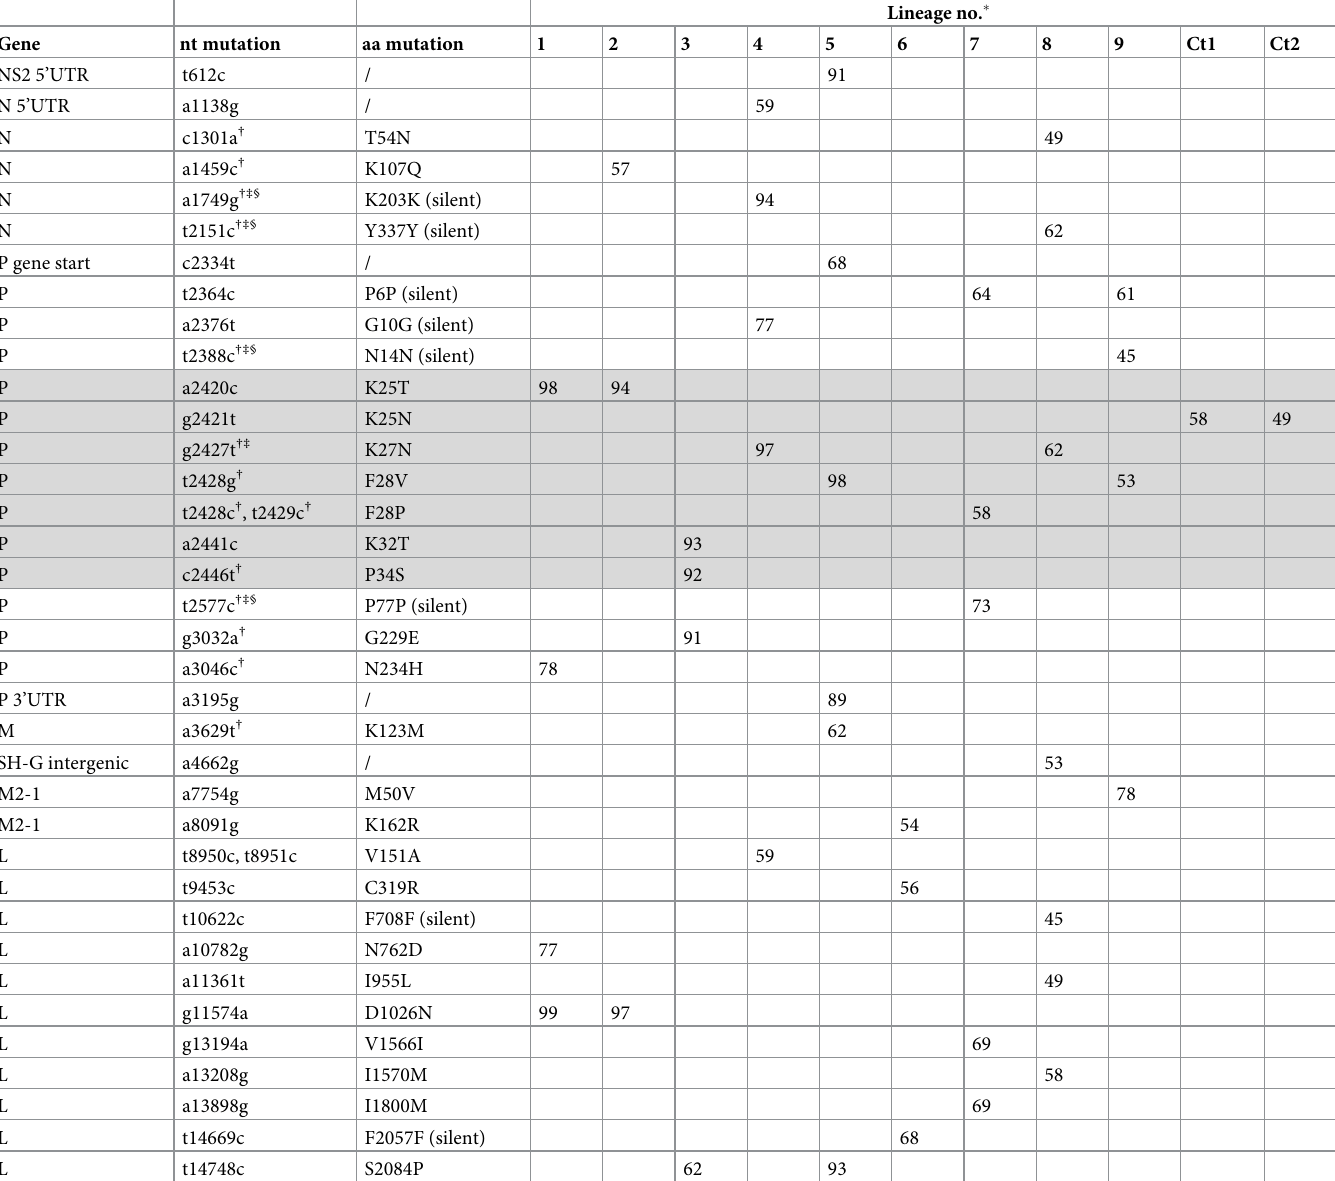
Table 1. Mutations detected at a frequency of � 45% in each of the nine Min A lineages at the end of the temperature stress test (passage 18) as well as in each of the two controls.